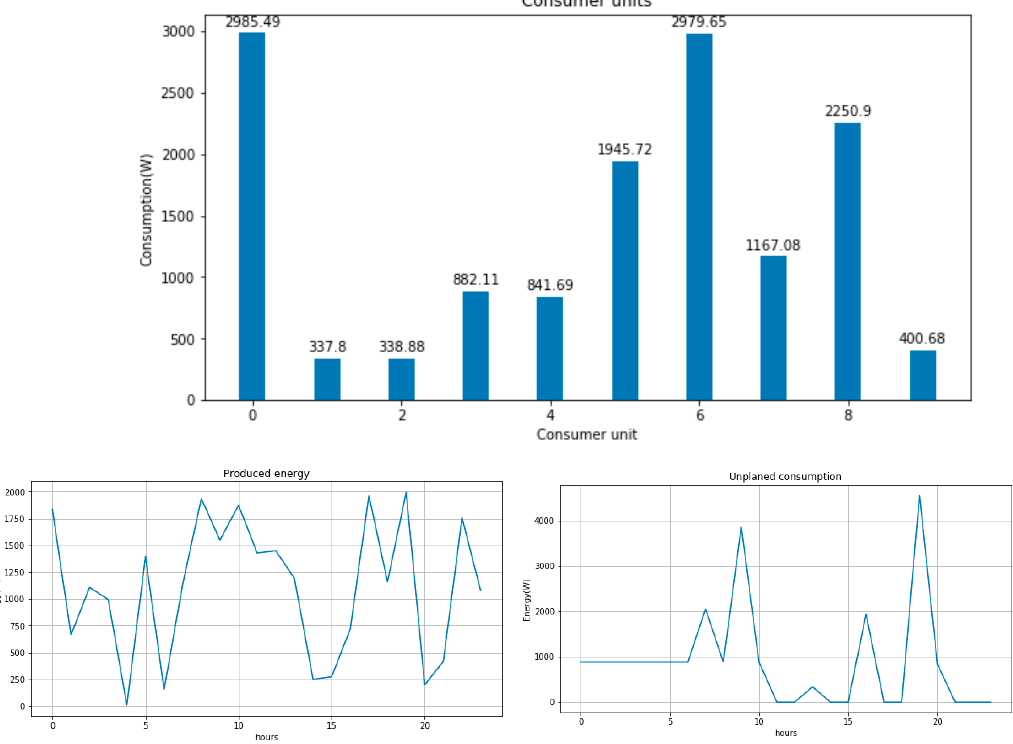
Figure 7. Simulated case study results. Top : consumers, bottom : distribution of energy produced and unplanned consumption distribution.